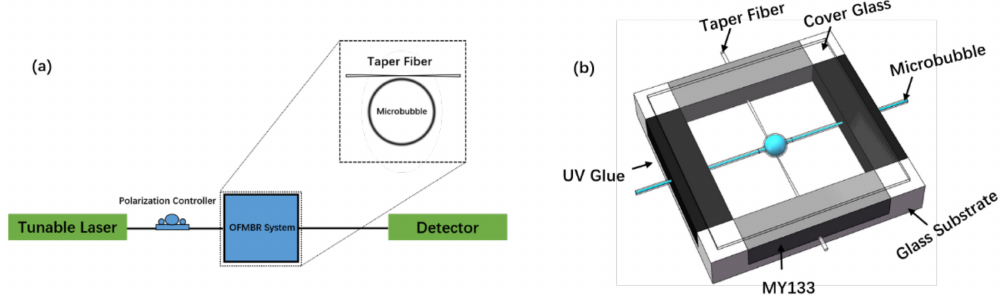
Figure 1. ( a ) Sketch of the detection system for the OFMBR sensor; ( b ) Structure of the packaged OFMBR